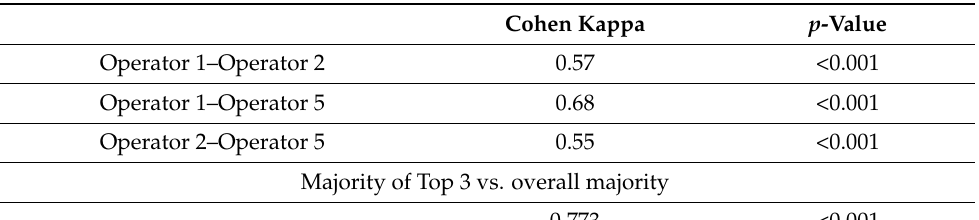
Table 5. The agreement for need of